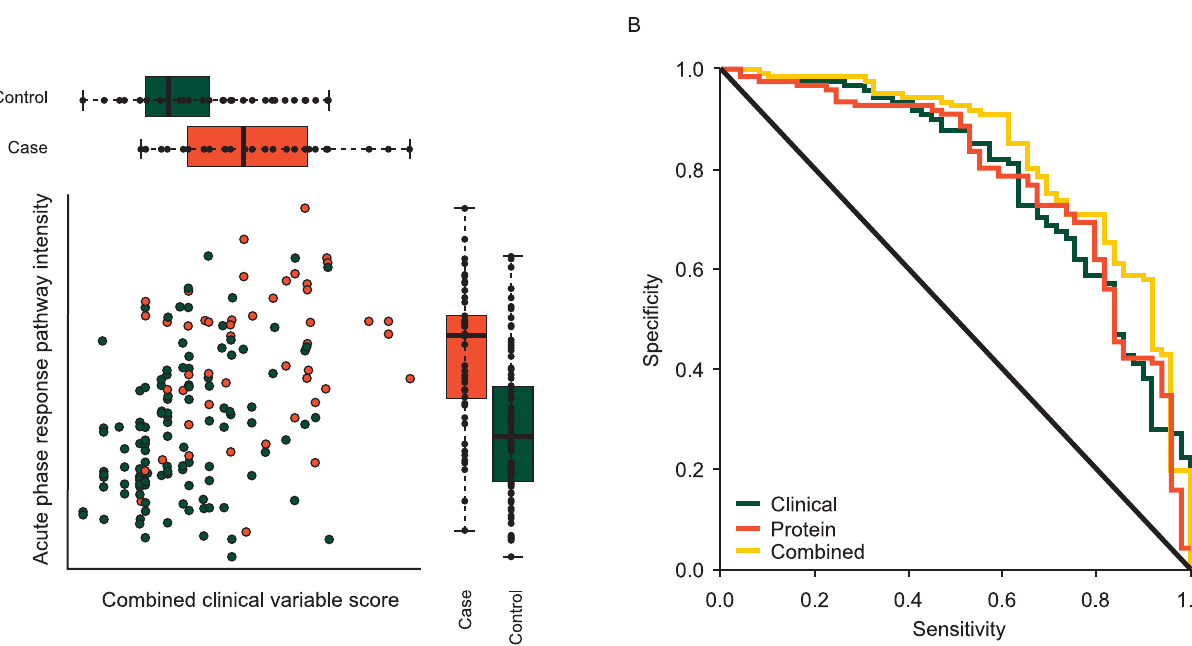
Figure 8. Plots illustrating the relationship between acute phase response pathway intensity score and clinical variable score. (A) Plot of the acute phase response intensity against the combined clinical variable score measuring the likelihood of a subject being a case calculated from a model predicting case-control status based only on the clinical variables WHO PS, smoking history, extent of normal lung coverage on CT scan, and severity of pre-existing ILD, with boxplots comparing the distribution of these measures in cases and controls. In each boxplot, the upper/right and lower/left sides of the box represent the higher and lower quartile values (Q3 and Q1), respectively. The black bar in each box represents the median value. (B) Receiver operating characteristics curve of cross-validated predictions from clinical data, the acute phase response intensity and a combination of the clinical data and acute phase response intensity.